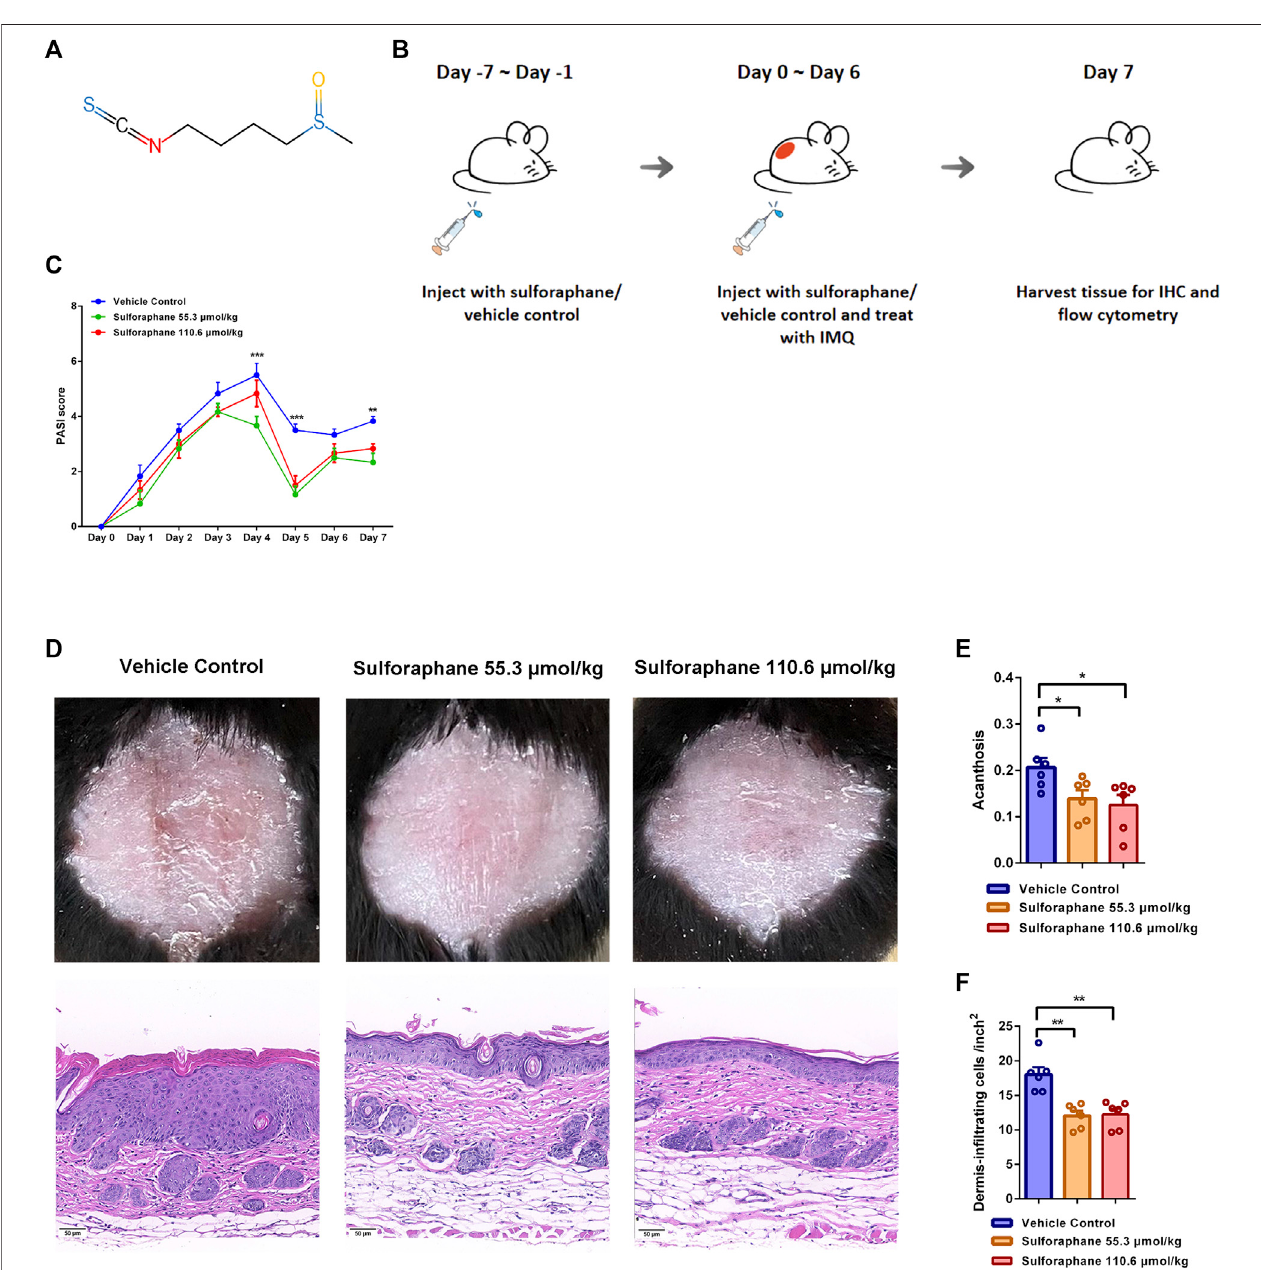
FIGURE 1 | Effects of sulforaphane on IMQ-induced psoriasis-like mouse model. (A) The structure of sulforaphane. (B) Schematic diagram of sulforaphane administration (55.3 and 110.6 μ mol/kg, i.p.) or vehicle control for 7 consecutive days before IMQ treatment, followed by daily treatment with 78 mg of IMQ cream (5%) on the shaved back and injection with sulforaphane or vehicle control for 7 consecutive days. (C) PASI scores of mice in each group (n (cid:1) 6). Compared with vehicle control, PASI scores were signi fi cantly decreased in mice treated with sulforaphane (55.3 μ mol/kg) on Day 4, 5, and 7 and in mice treated with sulforaphane (110.6 μ mol/kg) on Day 5. (D) Appearance and H&E staining of lesional skin from mice that were administrated with sulforaphane or vehicle control. Scale bars: 50 µm. (E, F) Quantitation ofacanthosisand dermalin fl ammatorycellin fi ltration wasperformedineach group.Thedatarepresent themean ± SEM.* p < 0.05,** p < 0.01,*** p <